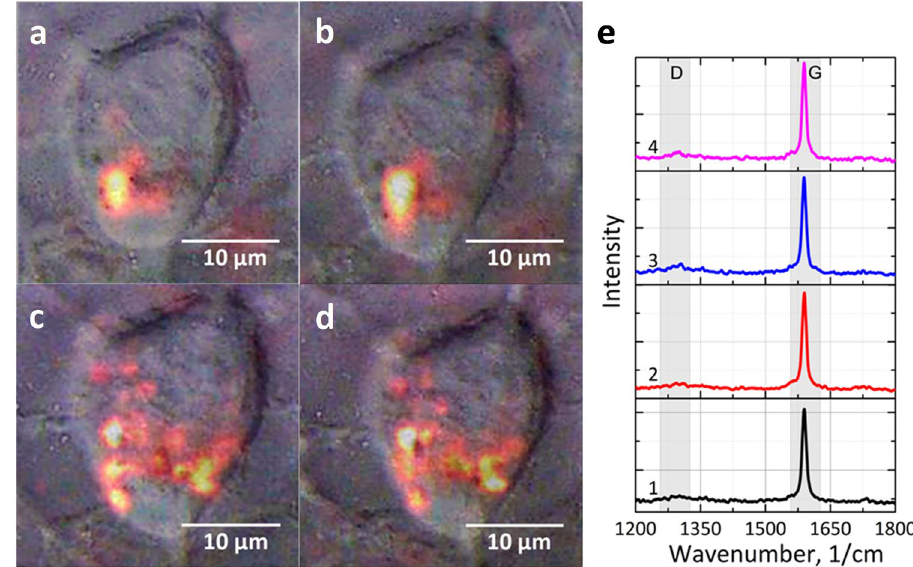
Figure 2. Intracellular accumulation of SWCNTs and structural integrity of C6 glioma cells exposed to continuous laser irradiation with λ ex = 785 nm. ( a – d ) images of C6 cells in reflected light superimposed on the map of the Raman G-mode of SWCNTs; ( e ) Raman spectra of SWCNT agglomerates inside the cell. The cell image ( a ) and Raman spectrum ( e-1) are taken before laser exposure. The cell image ( b ) and Raman spectrum ( e-2 ) are taken after irradiation of the cell by a laser beam at the intensity of 7.2 × 10 3 W/cm 2 for 10 min. The cell images ( c , d ) and Raman spectra ( e-3,e-4 ) correspond to cells before and after laser irradiation for 30 min at the intensity of 2.4 × 10 6 W/cm 2 ,